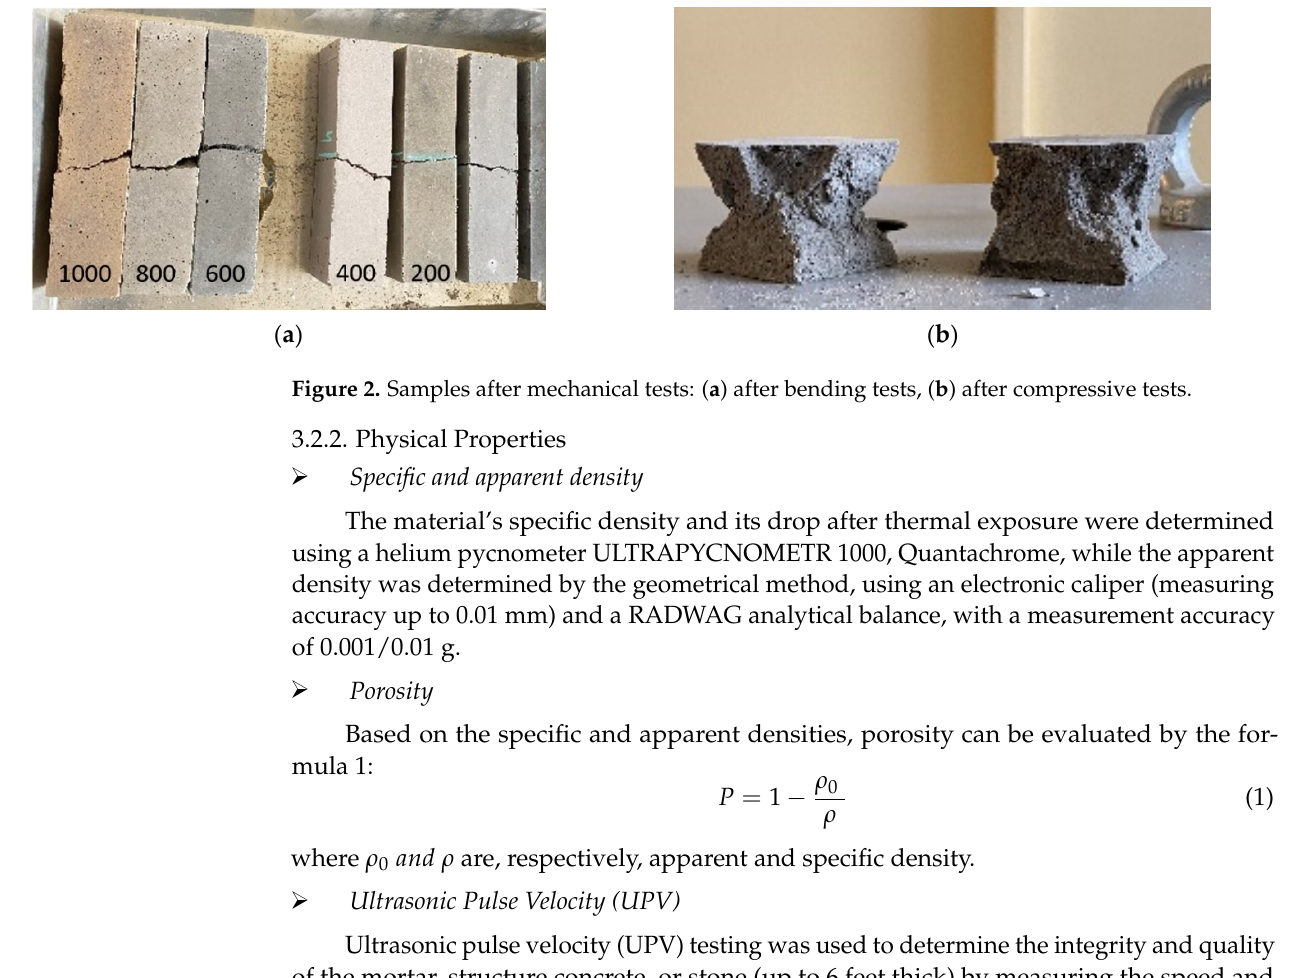
Figure 2. Samples after mechanical tests: ( a ) after bending tests, ( b ) after compressive tests.